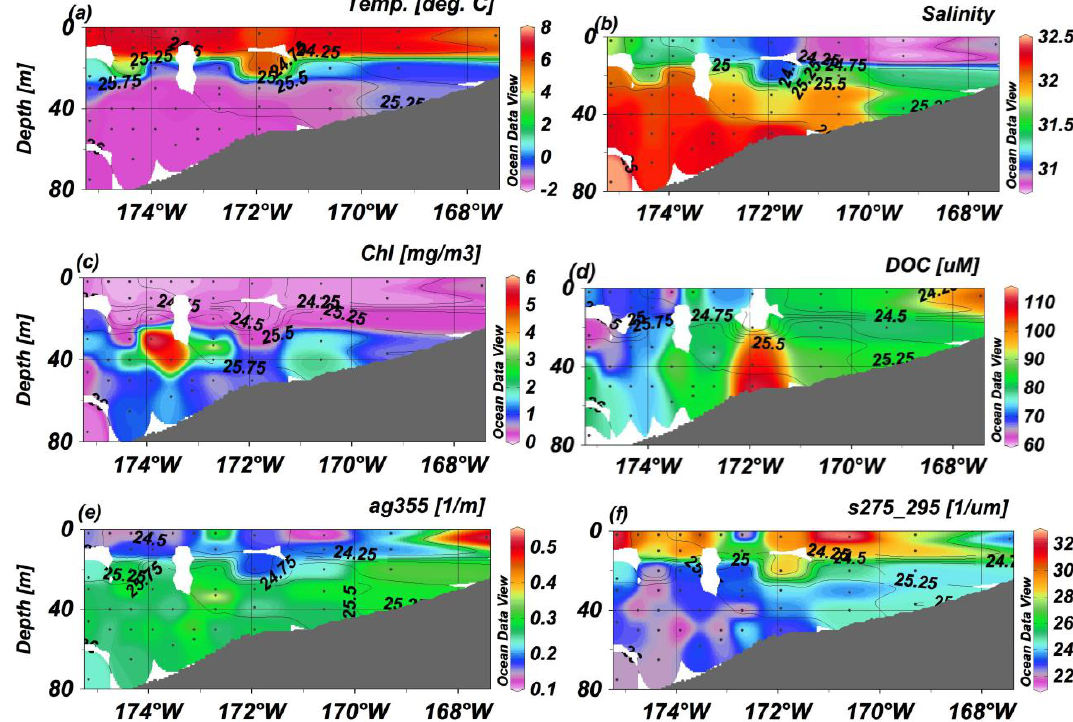
Figure 5. Vertical section of (a) temperature, (b) salinity, (c) Chl, (d) DOC, (e) a g 355, and (f) S 275 − 295 along SL transect with overlain contour lines of